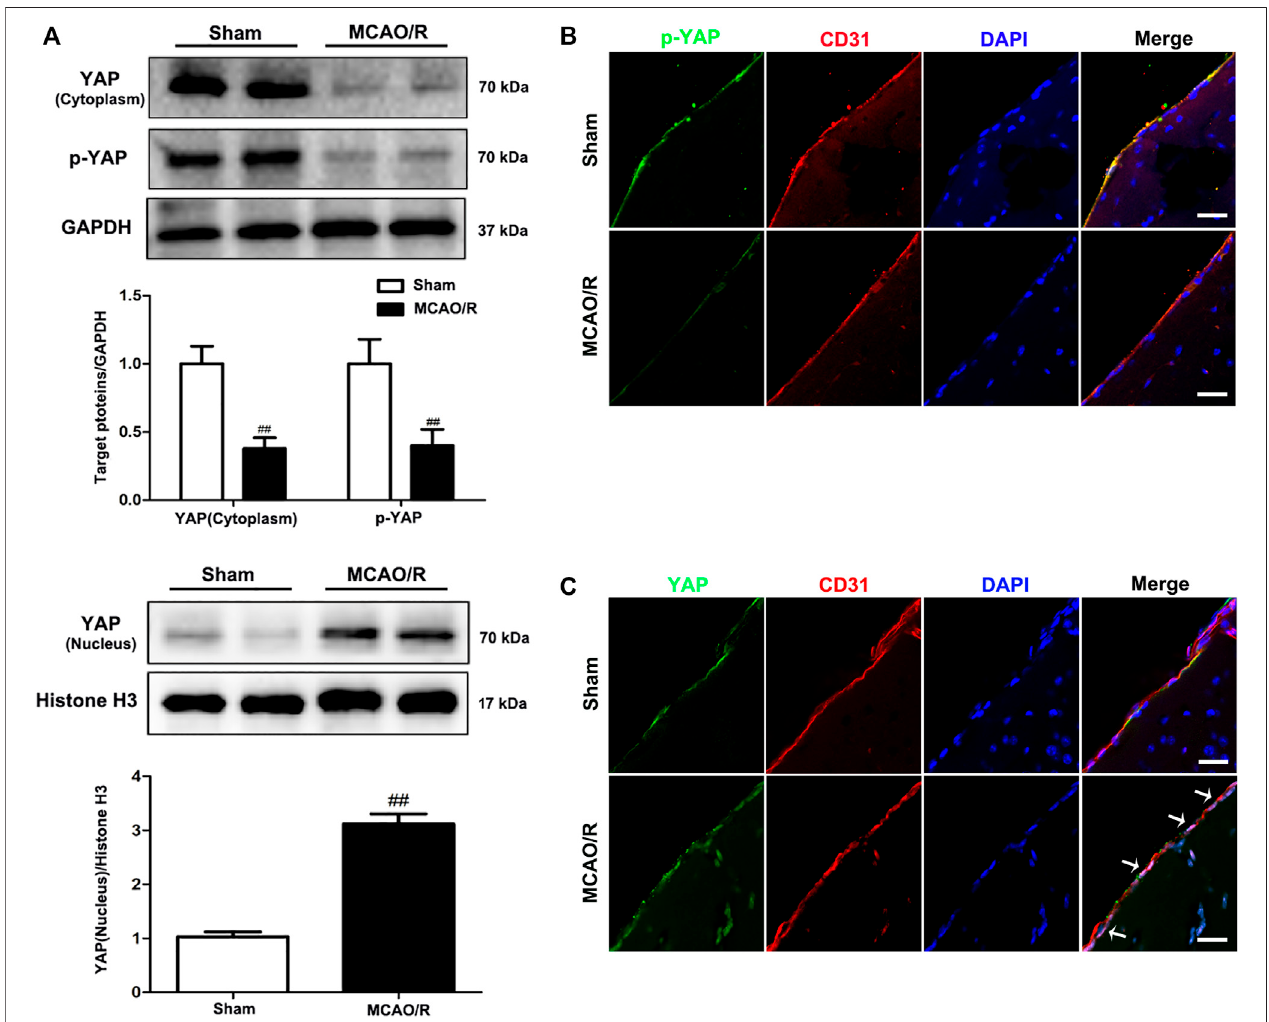
FIGURE 1 | Expression of YAP/p-YAP in the brain endothelial cells following MCAO/R-induced injury. Mice were subjected to 1 h of ischemia and 24 h of reperfusion. (A) MCAO/R-inducedchangesinYAP/p-YAPproteinexpressionlevelsinthecytoplasmandnucleusweredetectedbywesternblottinganalysis. (B) and (C) MCAO/R-inducedchangesinYAP/p-YAPproteinexpressionlevelsweredetectedbyimmuno fl uorescenceanalysisusingacombinationofanti-YAP(green),anti-p-YAP (green),CD31(red)andDAPI(blue)staininginmice.ThewhitearrowrepresentsthenumberofYAPproteinintothenucleus.Scalebar (cid:1) 50 µm.Dataareexpressed as the mean ± SD, n (cid:1) 3. ## p < 0.01 vs . Sham